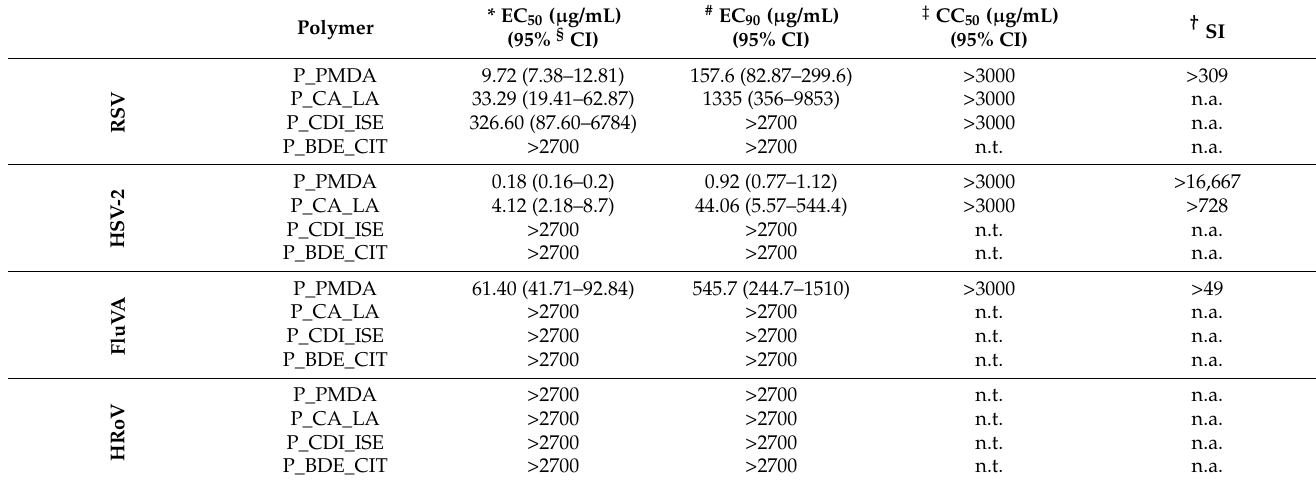
Table 2. Antiviral activity of β CD-based polymers against RSV, HSV-2, FluVA, and HRoV. * EC 50 Polymer